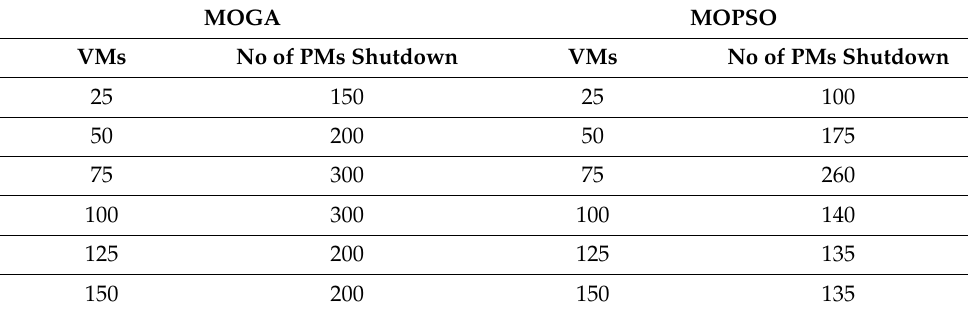
Table 5. PM shutdown with VMs for MOGA and